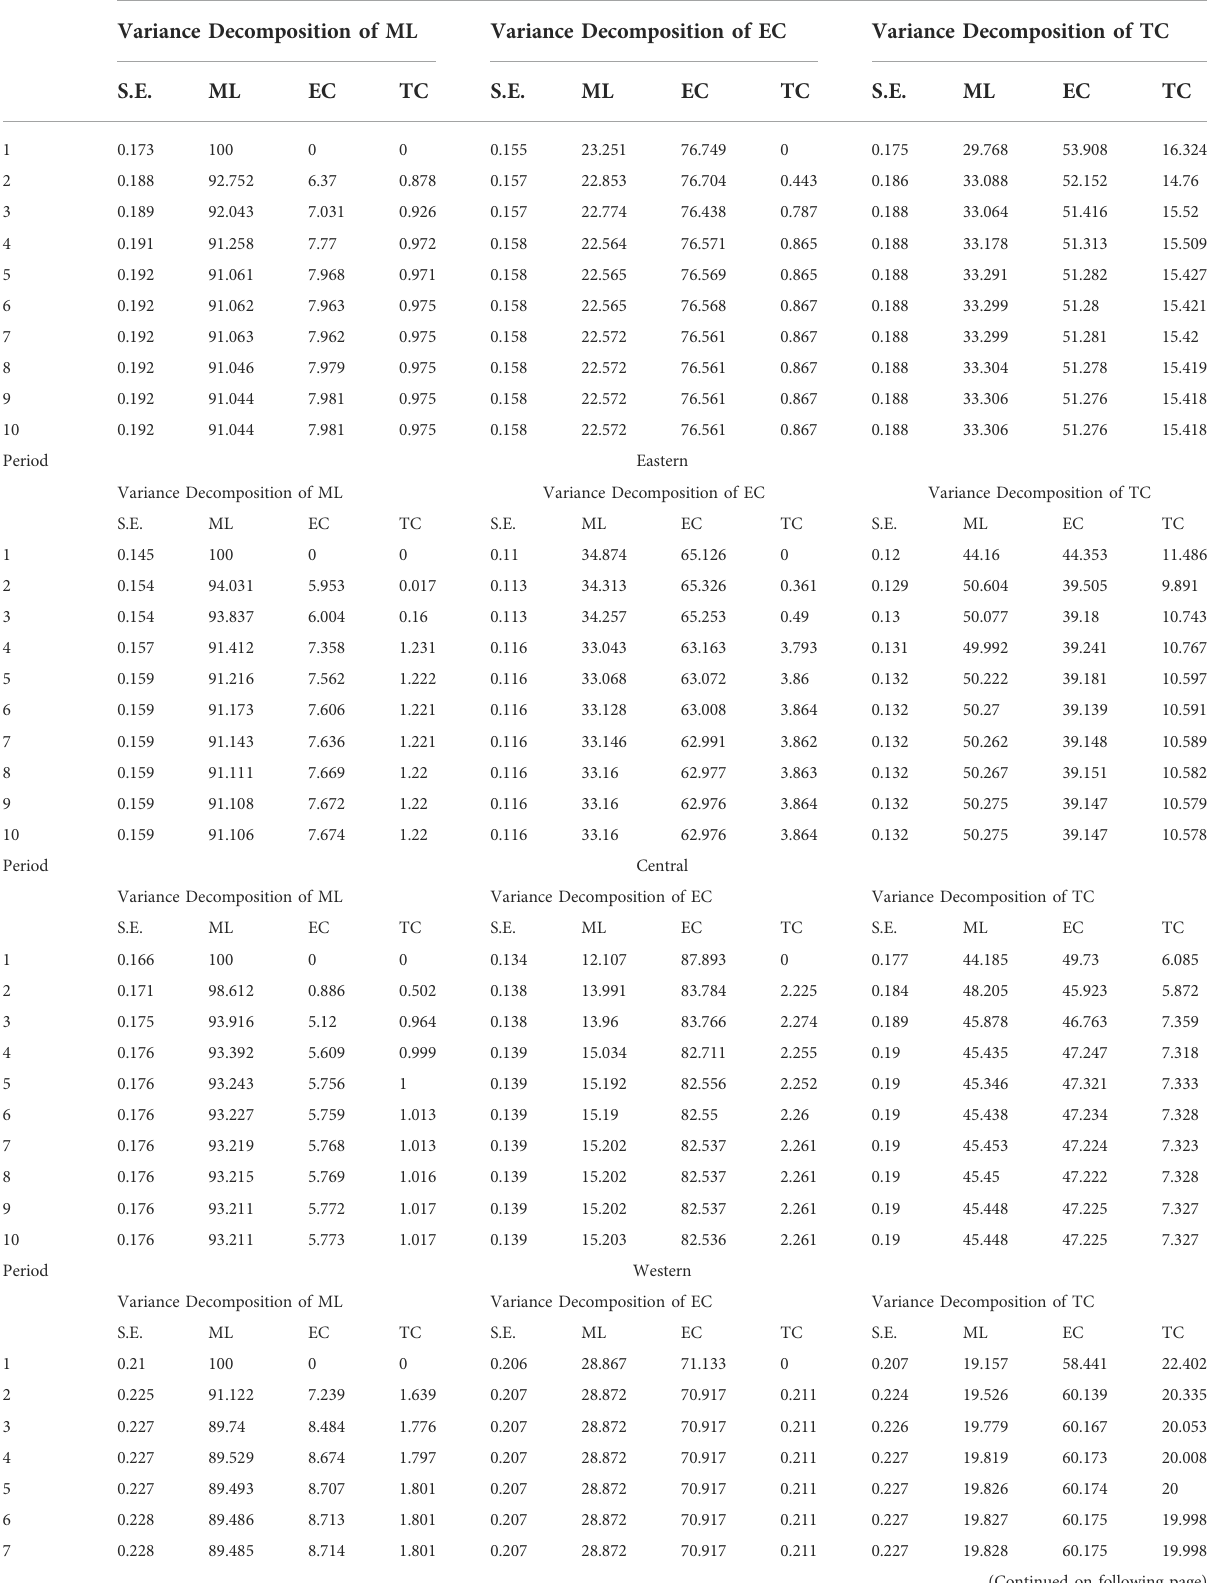
TABLE 9 Variance decomposition of ML , EC and TC of DEIECE in various regions.